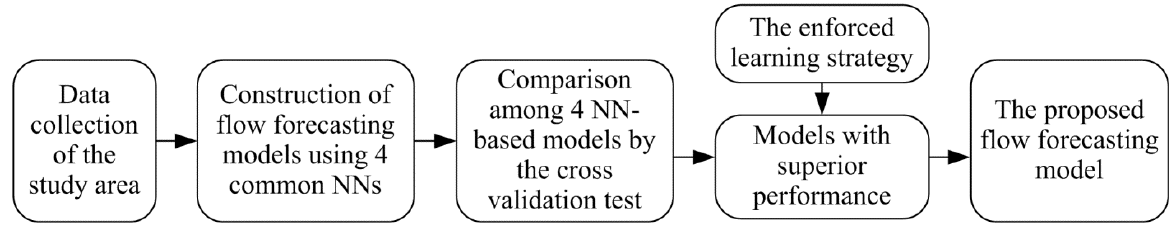
Figure 1. Flowchart of the development of the proposed flow forecasting